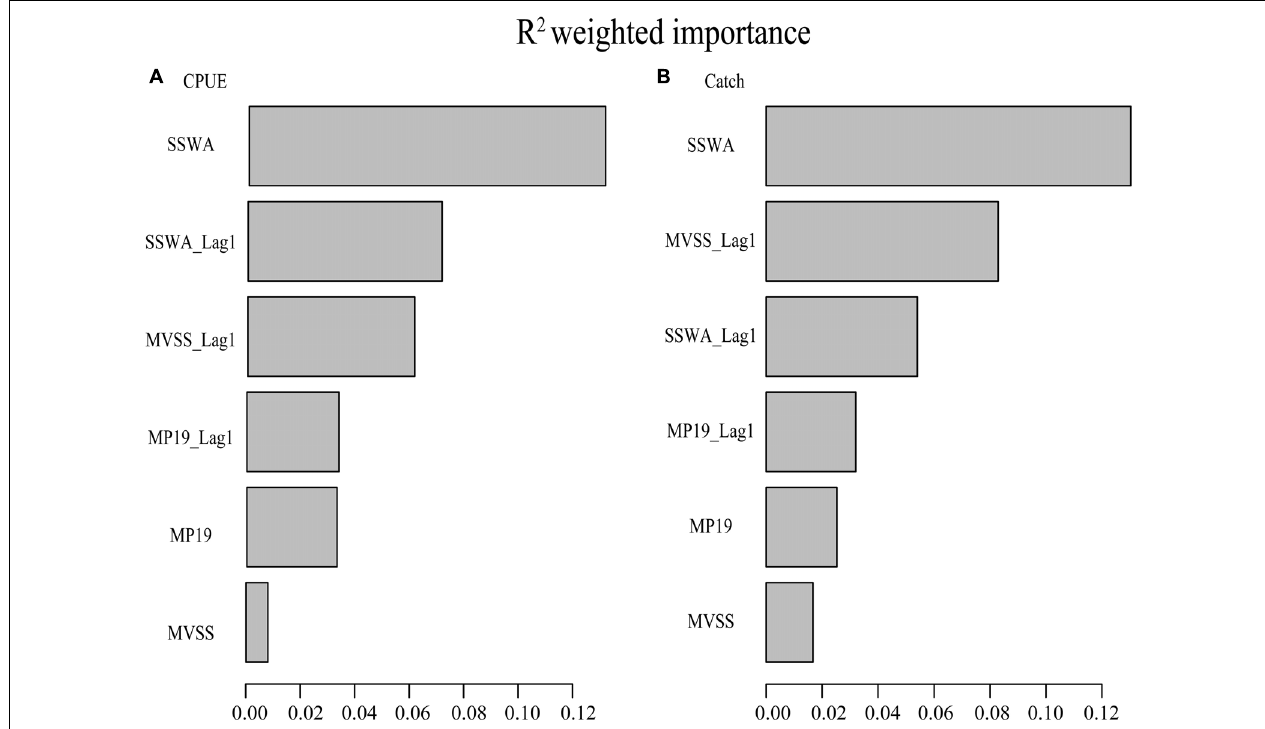
FIGURE 7 | Importance of spawning ground indices (SSWA, MVSS, MP19, MP20 and MP21) and their one-year lagged time series on CPUE (A) and Catch (B) from the gradientForest analyses.